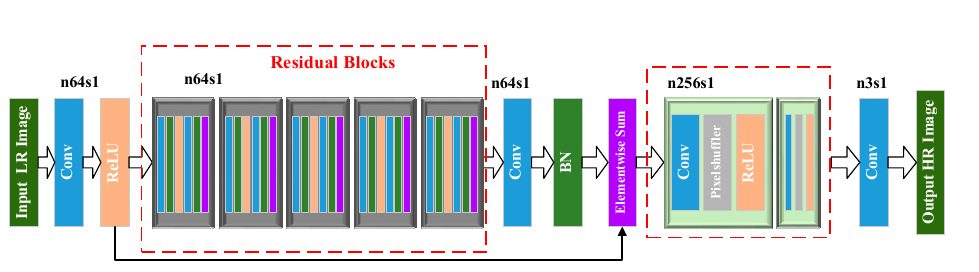
Figure 2. Architecture of SRGAN (“n” is the no. of feature maps, “s” is the stride of each convolutional layer): ( a ) generator, and ( b ) Discriminator. Figure 3. Schematic diagram of a residual block.